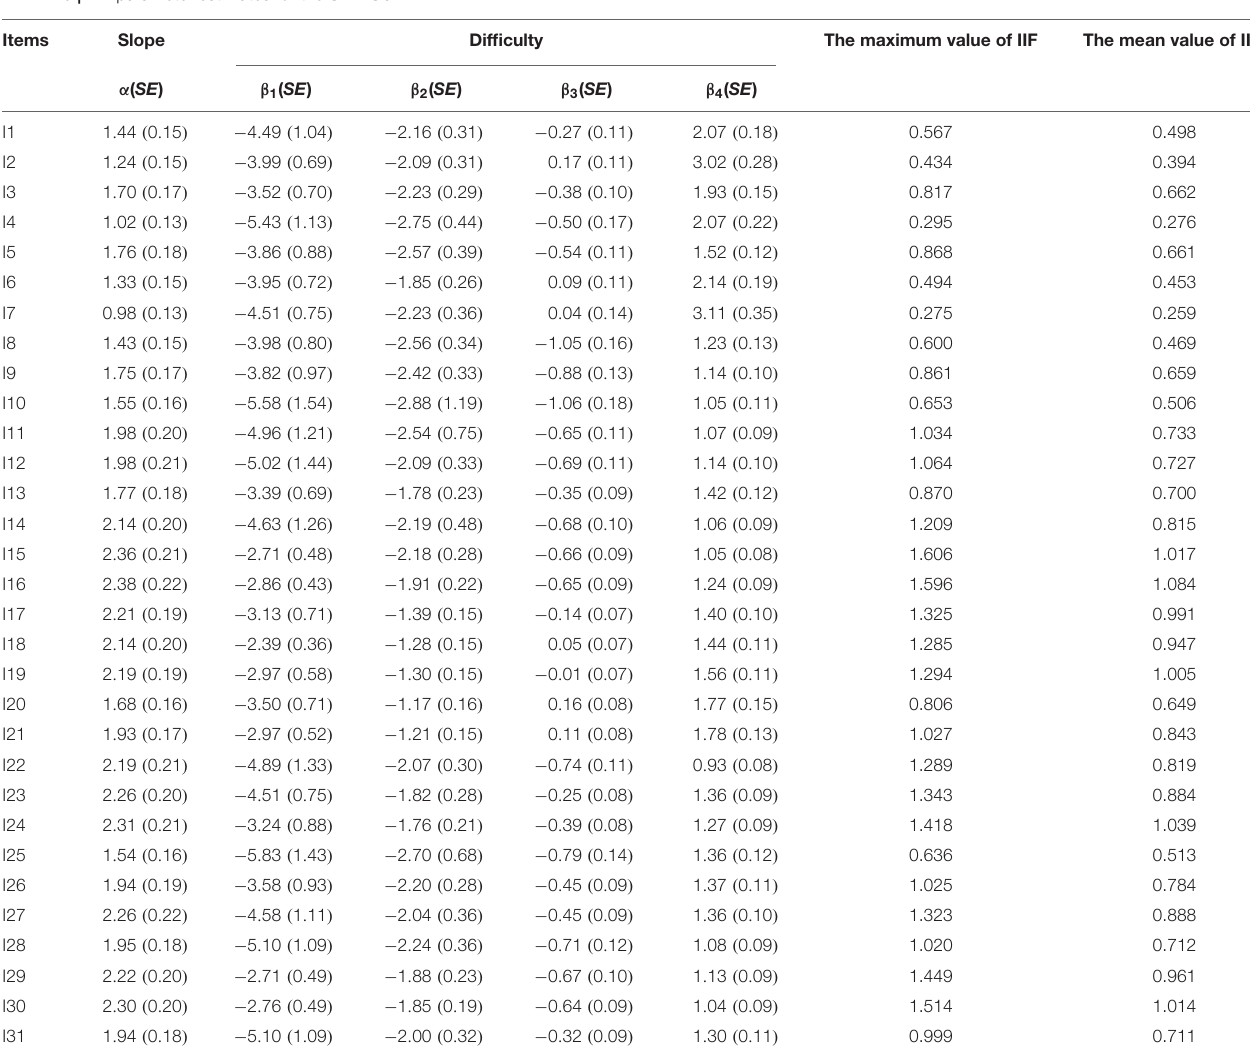
TABLE 3 | IRT parameter estimates for the